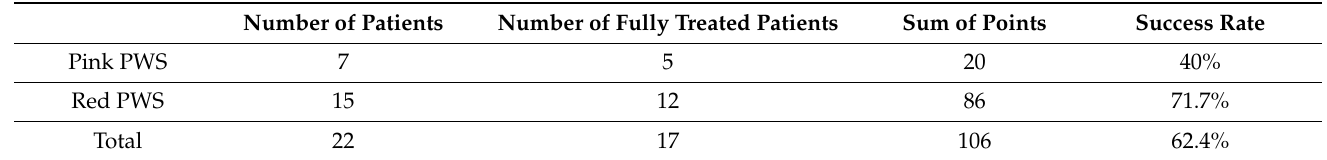
Table 3. Estimated results of treatment.